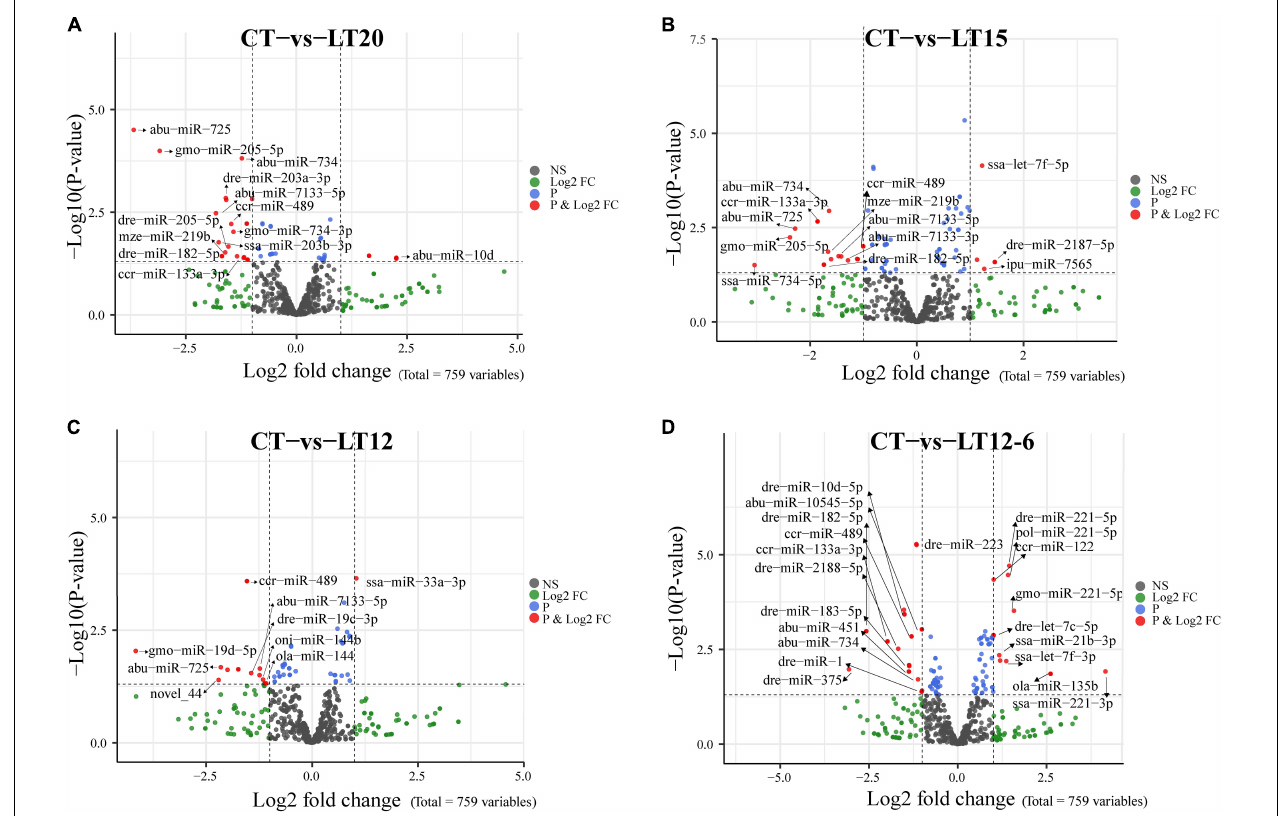
FIGURE 4 | Volcano plot showing the up-regulation or down-regulation of DE miRNAs in pairwise comparisons between the control group and four low-temperature groups. (A) Comparison of CT with LT20 groups. (B) Comparison of CT with LT15 groups. (C) Comparison of CT with LT12 groups. (D) Comparison of CT with LT12-6 groups. Dark gray dots (NS): miRNAs without significant differences between groups. Red dots ( P and Log2FC): miRNAs that meet the thresholds of P < 0.05 and log2FC >